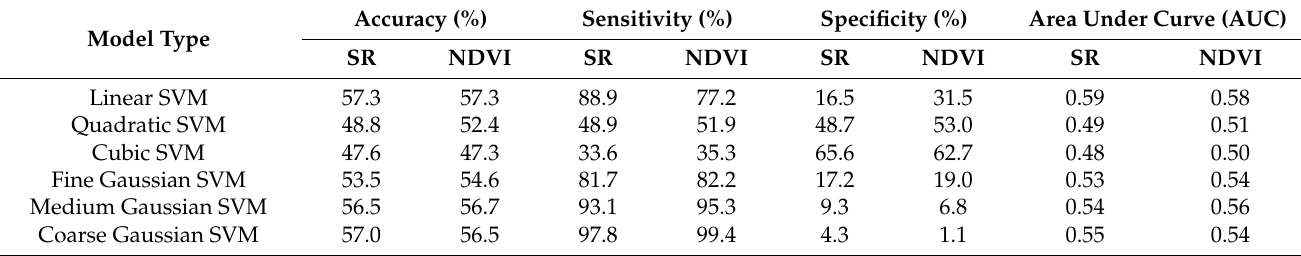
Table 8. Performance of SVM models using SR and NDVI datasets